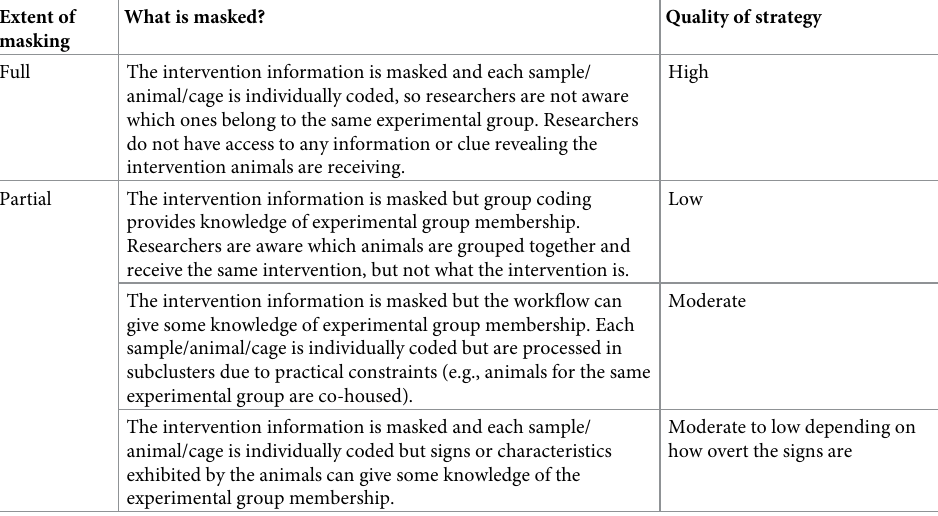
Table 3. Masking options during allocation, conduct, and outcome assessment. We have classified the masking options as either low, moderate, or high based on the ability to minimise risk of bias. Extent of